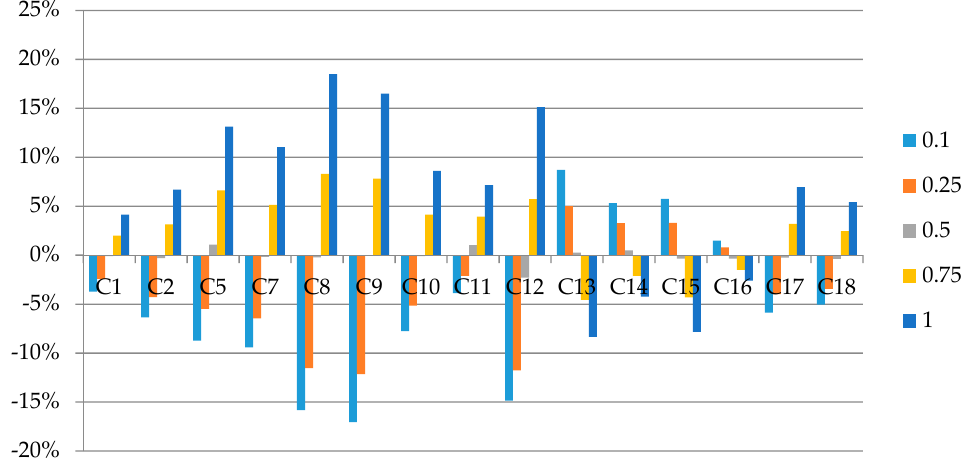
Figure 5. The impact of political factors on the other factors.